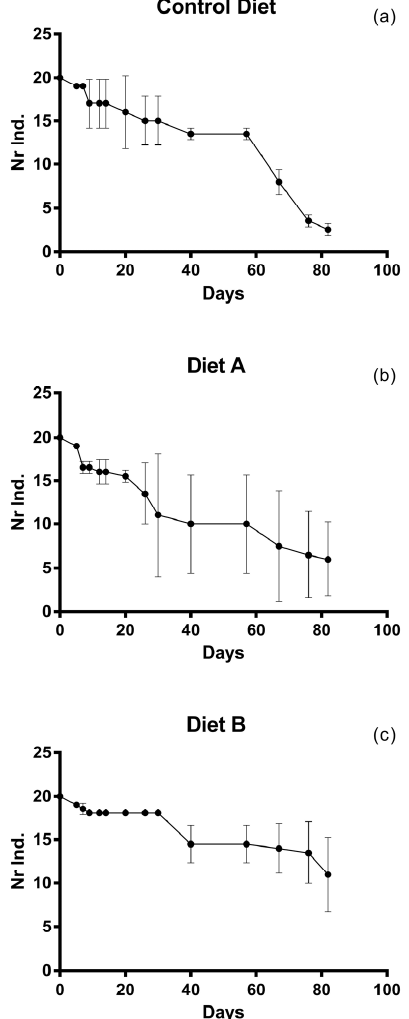
Figure 2. Mortality rates of post-larvae during the experimental period. Dots indicate the average number of individuals for each diet: ( a ) control diet ( U. rigida ); ( b ) diet A ( U. rigida , SHG ® microperle, Algamac Enrich); ( c ) diet B ( U. rigida , 2% spirulina SHG ® ).